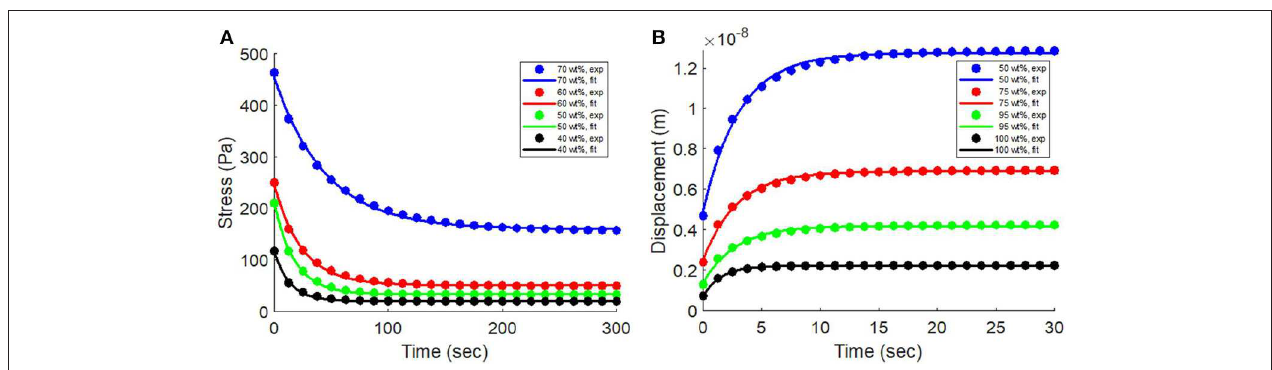
FIGURE 6 | (A) The stress relaxation behaviors of magnetorheological gels with different carbonyl iron particle concentrations (40, 50, 60, and 70 wt%) were curve fitted by Equation (7). (B) The creep behaviors of nanocomposite thin films with different CdSe quantum dot concentrations (50, 75, 95, and 100 wt%) were curve fitted by Equation